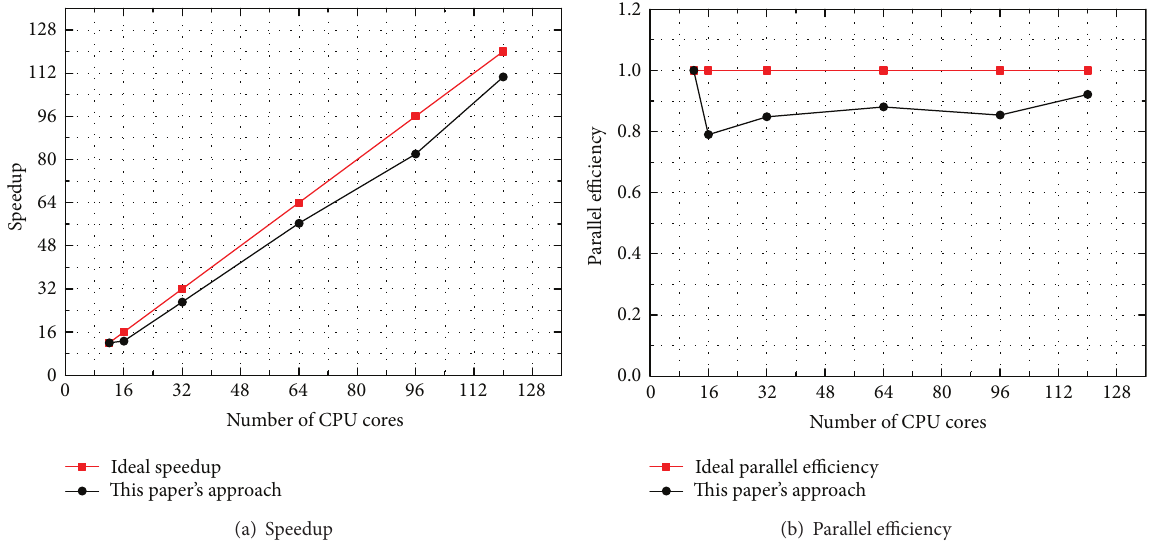
Figure 3: The speedup and parallel efficiency of the code from 12 CPU cores to 120CPU cores on